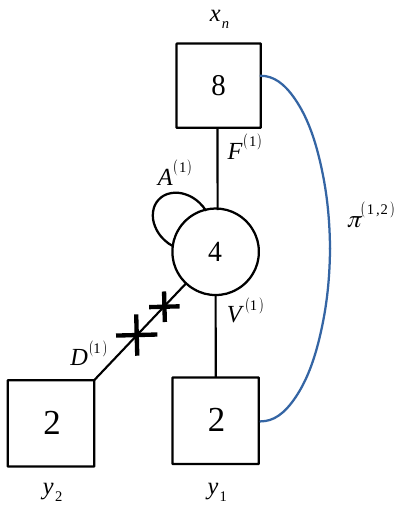
[USp(8)]. Two crosses with di(cid:11)erent [2 2 ]